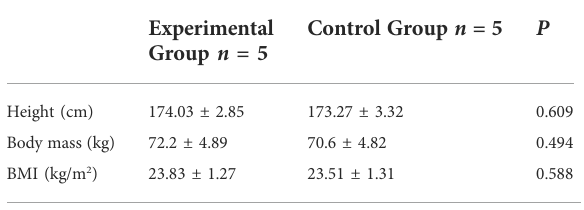
TABLE 1 Characterization of the